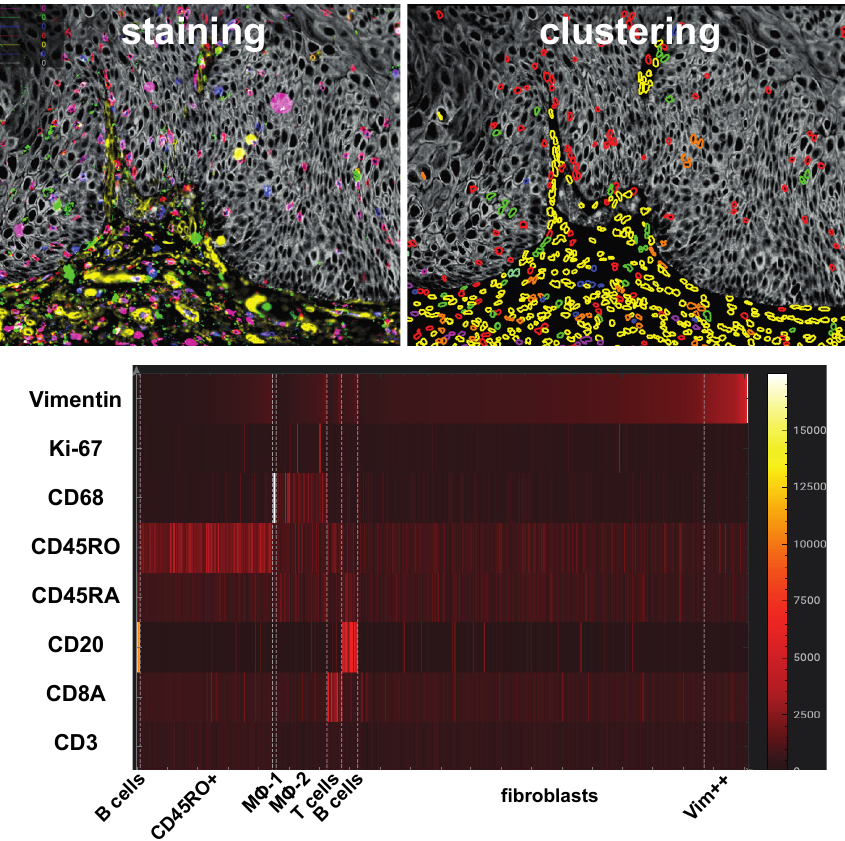
Figure 1. Example of a “simple” multiplex immunofluorescence staining using 18 antibodies on a Miltenyi MACSima instrument. For segmentation and clustering, the MACS iQ View software ver-